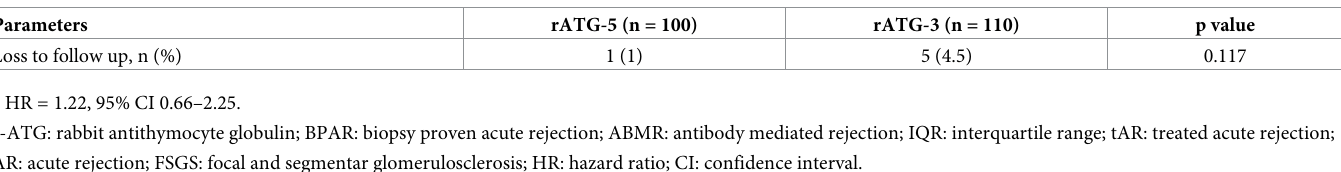
month 36 compared to patients in the rATG-3 group, with and without imputation, and mean urinary protein concentration was higher in the rATG-3 group at months 1, 24 and 36 (Table 5). The difference in eGFR was observed in patients without acute rejection, from month 1 (56.96 ± 29.85 vs. 44.96 ± 25.60 ml/min/1.73 m 2 , P < 0.001) to month 36 (53.25 ± 28.22 vs. 44.58 ± 24.00, p < 0.001, respectively (S3 Table). There were no significant differences in mean eGFR of recipients of living donor allografts, and of deceased donors allografts with KDPI < 20% (Table 5, S2 Fig). Finally, there were no significant differences in renal function trajectories over the study period (Fig 3). The differences in eGFR at month 1 and month 12 were influenced by the unbalanced distribution of donor and recipient sex mismatches (S4 Table). Yet only the rATG-3 group (OR 2.93) and DGF (OR 2.46) were associated with inferior ( < 48 ml/min/1.73 m 2 ) eGFR at 1 month (Table 6). A higher proportion of patients in the rATG-3 group required at least one biopsy, either early or late after transplantation, and the number of biopsies per patient was also higher com- pared to patients in the rATG-5 group. Biopsies of patients in the rATG-3 group showed higher cg scores, early (0–3 months) and late (4–36 months) after transplantation. Nonethe- less, there was no statistical difference in mean total Banff scores, either in biopsies performed within the first 3 months or afterwards (Table 7).